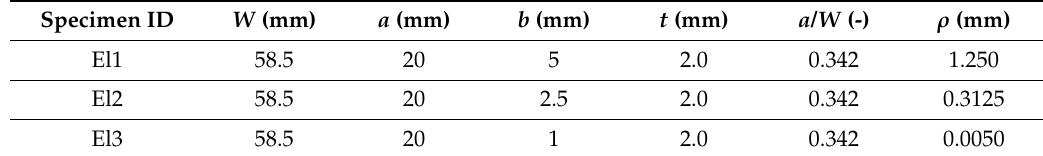
δ applied along the y -axis. Table 1. Geometric characteristics of the thin plates with elliptical notches. The rightmost column contains the values of the initial notch root radius ρ = b 2 / a